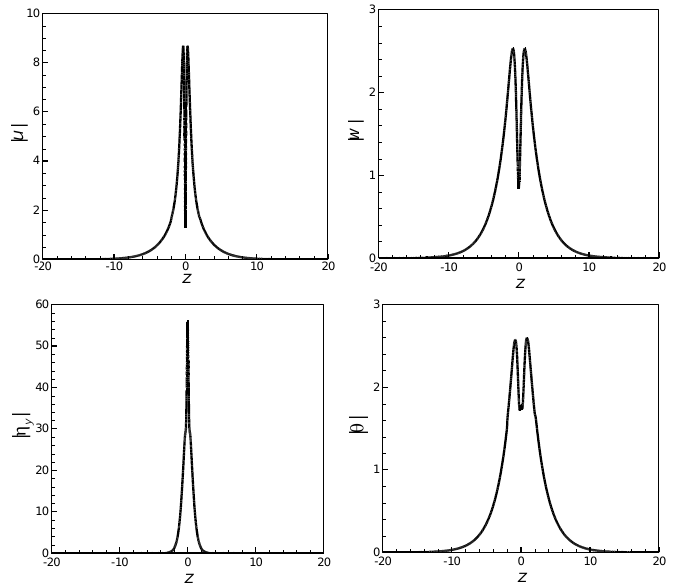
Figure 2. Amplitudes of the initial optimal disturbance for 𝑅𝑖 = 1,𝑅𝑒 = 1000,𝛼 = 0.5,𝛽 = 0 yielding the maximal transient growth at 𝑡 = 10 . To investigate the non-modal growth mechanism, we plot spatial patterns of optimal vector time evolution. Figure 3 shows that the u -velocity component’s evolution is repre- sented by two waves traveling in the opposite direction to the mean flow. Such a behavior can be a replication of the well-known Holmboe instability mechanism [16].